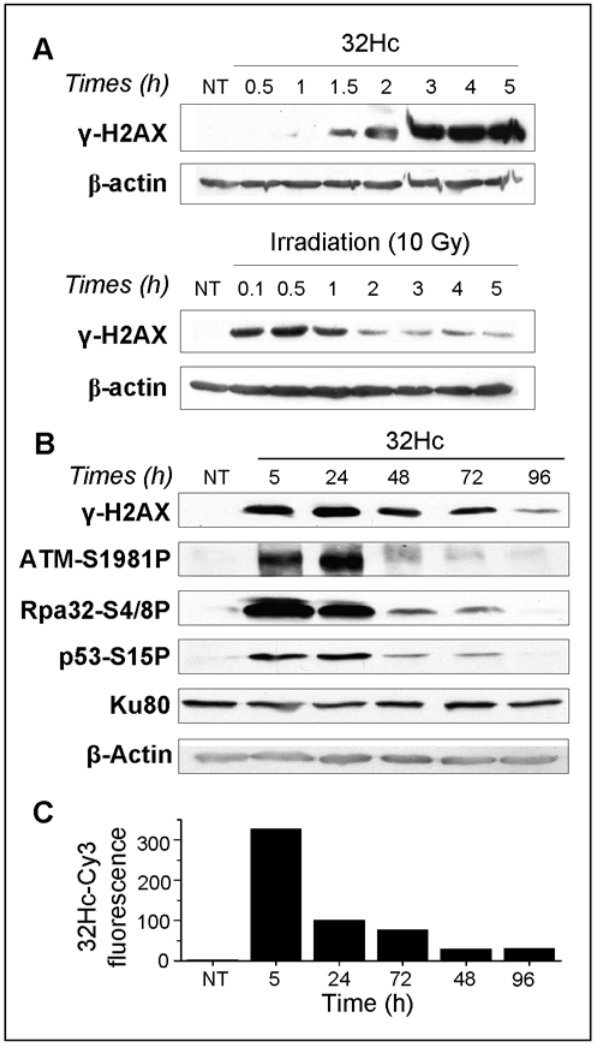
Figure 2. Kinetics of the 32Hc induced response. (A) MRC-5 cells were transfected or irradiated at time 0 and then extracted for western blot analysis of c -H2AX and b -actin at the indicated times. (B-C) To monitor the kinetics of DNA-PK target protein phosphorylation and 32Hc elimination, cells were transfected with Cy3-conjugated 32Hc and (B) one part of each sample was processed for SDS-PAGE and hybridized with antibodies against b -actin, Ku80, and phosphorylated p53, Rpa32 and H2AX. Phosphorylated ATM was revealed on a separate gel due to its higher molecular weight. (C) In parallel, the other part of the sample was analyzed by flow cytometry for the mean Cy3- fluorescence.